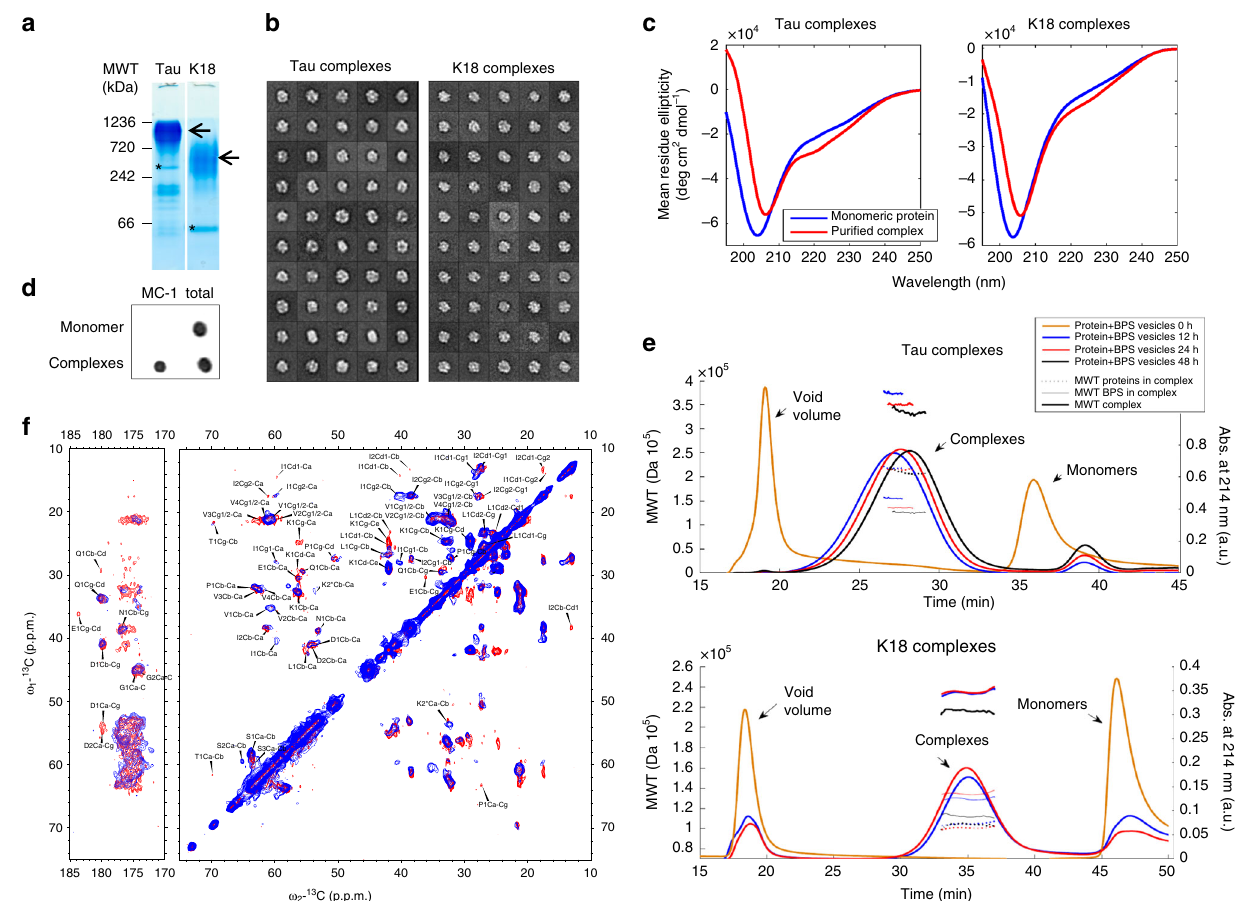
Fig. 3 Structural characterization of Tau and K18 protein/phospholipid complexes. a NativePAGE analysis of protein/phospholipid complexes formed by Tau (left) and K18 (right) after 24 h of incubation with BPS vesicles at a molar protein:phospholipid ratio of 1:20. The monomer bands are indicated by asterisks, and the presence of higher molecular weight bands, indicated by arrows, demonstrates that the protein/phospholipid complexes contain oligomerized proteins. b Averages obtained from the classi fi cation of ~4850 particles of Tau with a radius ranging from 100 to 110 Å and ~4000 particles of K18 with a radius ranging from 81 to 97 Å into 50 classes. c CD spectra of Tau (left) and K18 (right) alone (blue) and their phospholipid complexes (red) formed by incubation with BPS vesicles at a molar protein:phospholipid ratio of 1:20. The formation of protein/phospholipid complexes is accompanied by a slight increase in secondary structure content. d Dot blots (0.25 µ g) of Tau monomer or Tau incubated for 4 days with BPS vesicles at 37 °C. Tau was detected using the MC-1 antibody (dilution 1:500), which recognizes pathological Tau conformations, and a homemade rabbit polyclonal anti-Tau antibody (dilution 1:5000) to assess the total amount of protein. e Determination of the molecular weight of protein/phospholipid complexes formed by Tau and K18 by multi-angle light scattering. Although the number of subunits in the complex remains constant (5 for Tau and 7 – 8 for K18), the number of phospholipid decreases over time (from ~190 to ~150 for Tau and from ~160 to ~140 for K18). The fi nal molecular weight of the protein/phospholipid complexes formed by Tau and K18 are ~335 kDa and 230 kDa, respectively. f Residue type assignments of [U-13C/15N]-labeled K18/phospholipid complexes using 2D DARR solid-state NMR spectra. Mixing times for DARR are 20 ms (blue) and 150 ms (red). Both spectra were recorded at 17.6 T, 278 K, and 13 kHz magic-angle